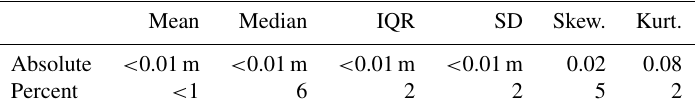
Table 2. Percent and absolute difference between various statistical metrics computed from geo-rectified and non-geo-rectified (no ground control points) DEMs produced from data collected at DRLL06, 13 November 2019. Mean Median IQR SD Skew. Kurt. Absolute < 0.01m < 0.01m < 0.01m < 0.01m